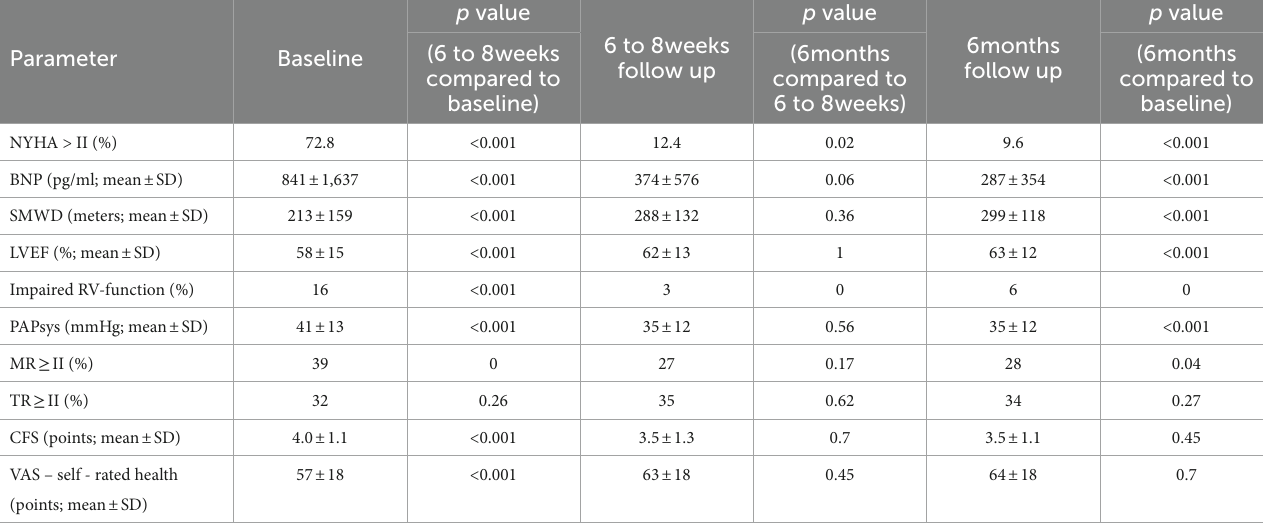
TABLE 2 Outcome measures of the study